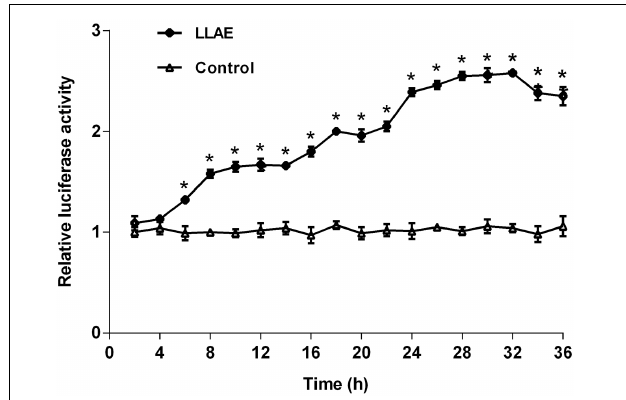
FIGURE 3 | Effects of different action time of LLAE on PPAR γ 2 promoter activities in 3T3-L1 preadipocytes. Stably transfected 3T3-L1 preadipocytes were plated in 12-well plates at a density of 2.5 × 10 5 cells/well and cultured in medium with 100 µ g/ml LLAE for different time (2 ∼ 36 h). Then cells were lysed and the luciferase activities were measured. The relative luciferase activity was obtained in comparison with that of controls. The data represent the mean ± SD of three separate wells in three different colonies. ∗ P < 0.01 vs. controls (without LLAE treatment).